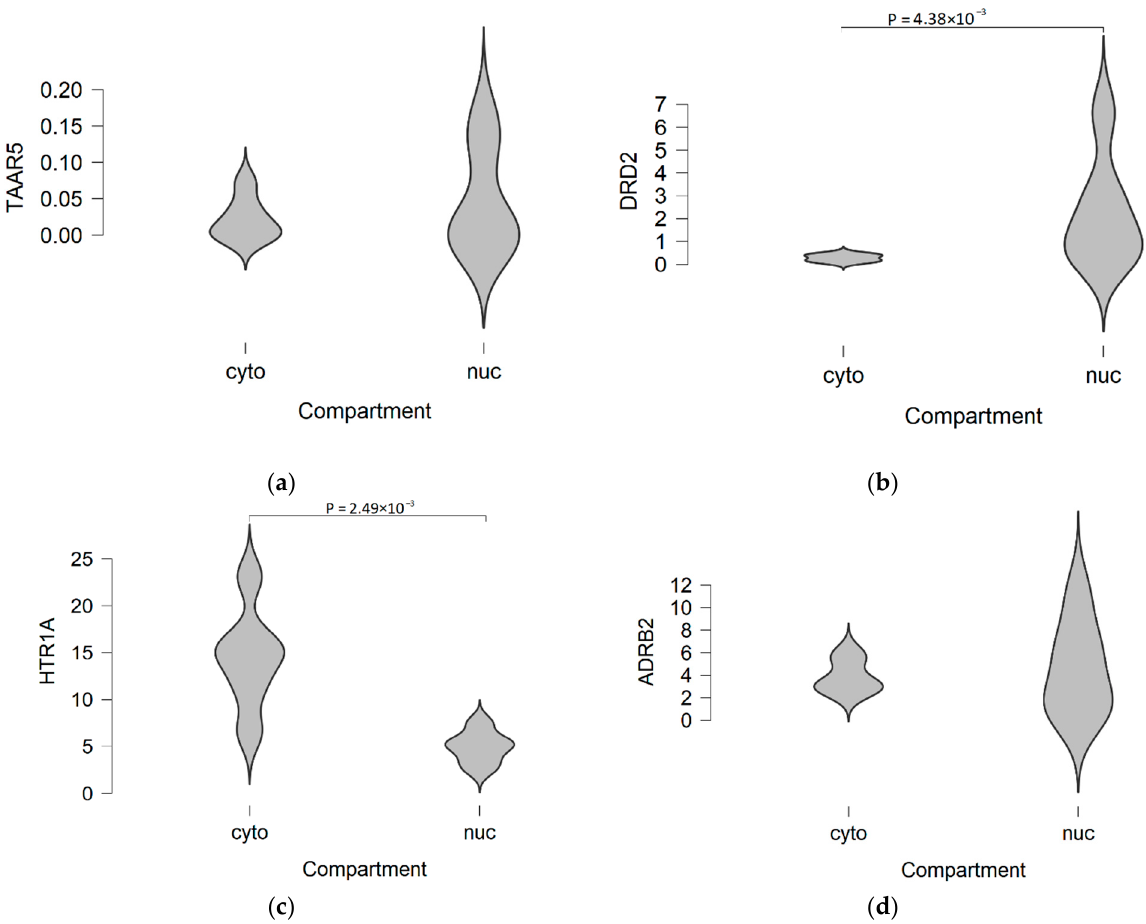
Figure 6. TAAR5, DRD2, HTR1A, and ADRB2 expression in cytoplasmic and nuclear fractions of healthy adult frontal cortex specimens in the RNAseq-generated dataset GSE110727. ( a ) TAAR5 mRNA distribution in cytoplasmic and nuclear compartments; ( b ) DRD2 mRNA distribution in cytoplasmic and nuclear compartments; ( c ) HTR1A mRNA distribution in cytoplasmic and nuclear compartments; ( d ) ADRB2 mRNA distribution in cytoplasmic and nuclear compartments. Cito–cytoplasmic expression, nuc—nuclear expression, data represented in CPM values.